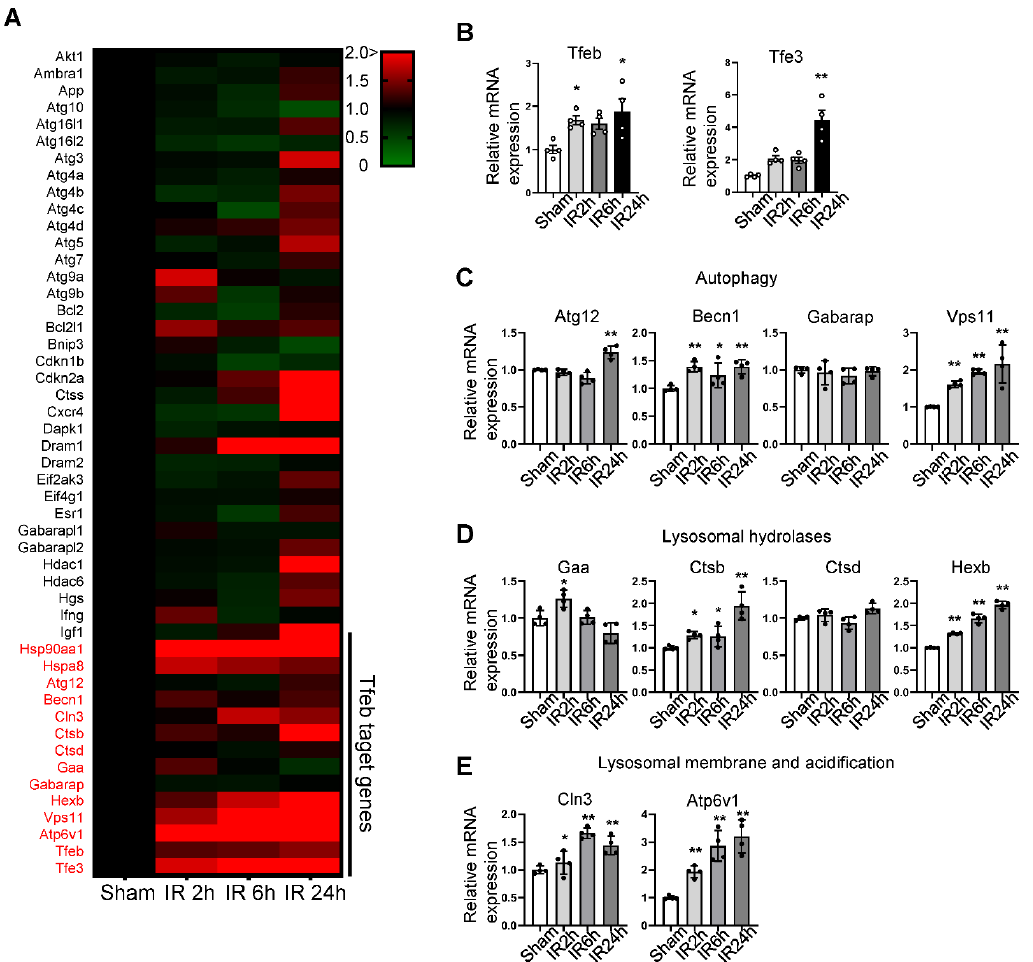
Figure 1. Pathway-focused qPCR array analysis shows a comparison of the autophagy and lysosomal gene profile in sham and I/R heart samples. An autophagy-related, pathway-focused qPCR array was performed using primers for 75 autophagy-related genes. Three-month-old C57BL/6J mice were subjected to 30 min of ischemia followed by reperfusion for the indicated times, and whole heart lysates were analyzed via qPCR analysis. ( A ) Heat map showing changes in gene expression levels relative to sham samples, indicated by color change. ( B – E ) Graphs showing relative gene expression levels of Tfeb and Tfe3, ( B ) autophagy-related (Atg) genes, ( C ) lysosomal hydrolase genes ( D ) and lysosomal-membrane- and acidification-related genes ( E ). Mean ± S.E., n = 4; * p < 0.05, ** p < 0.01 versus sham; 1-way ANOVA with Dunnett ’ s post hoc test.